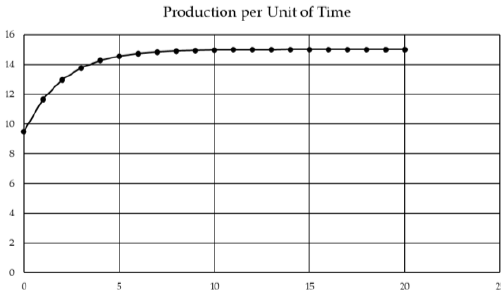
Figure 6. Three-parameter model graphic [20].